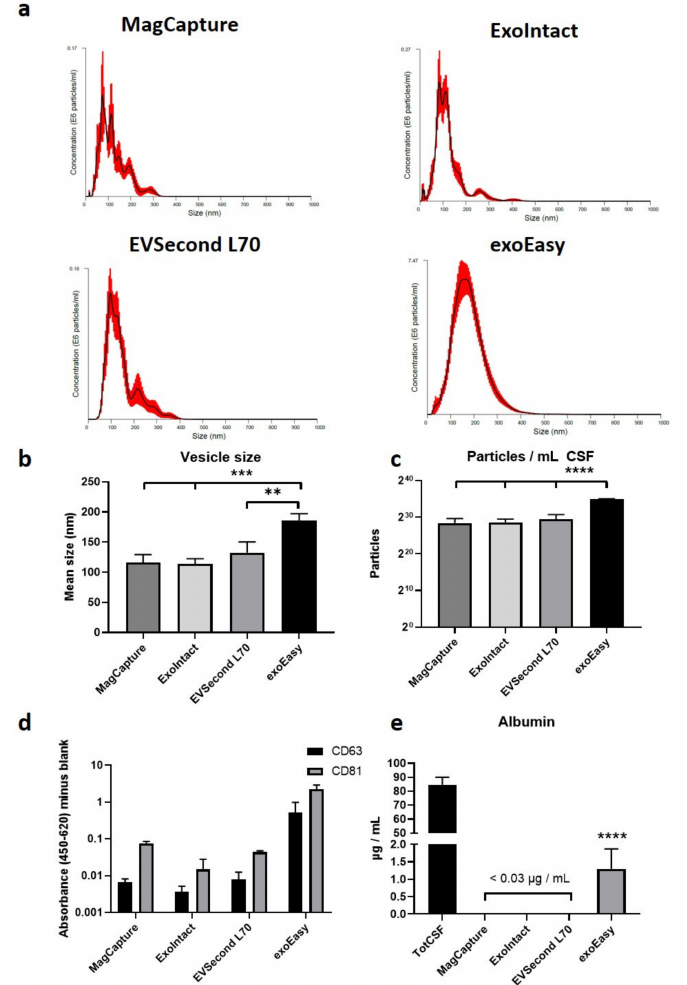
Figure 2. Characterization of extracellular vesicles. Nanoparticle tracking analysis was performed on samples isolated from each kit. ( a ) Representative histograms from each group. ( b ) The vesicle size was significantly larger for exoEasy samples than the other groups. ( c ) The number of isolated particles was considerably higher for exoEasy compared with the other groups. ( d ) EV markers CD63 and CD81 were detected in all groups (not measured quantitively). ( e ) Albumin, a common contaminant in EV preparations, was not detectable for MagCapture, ExoIntact, and EVSecond L70, and was heavily reduced in the exoEasy group. Significance was determined by one-way analysis of variance with Tukey’s multiple comparison tests, and labelled as ** p ≤ 0.01, *** p ≤ 0.001 and **** p ≤ 0.0001. Tot CSF: total